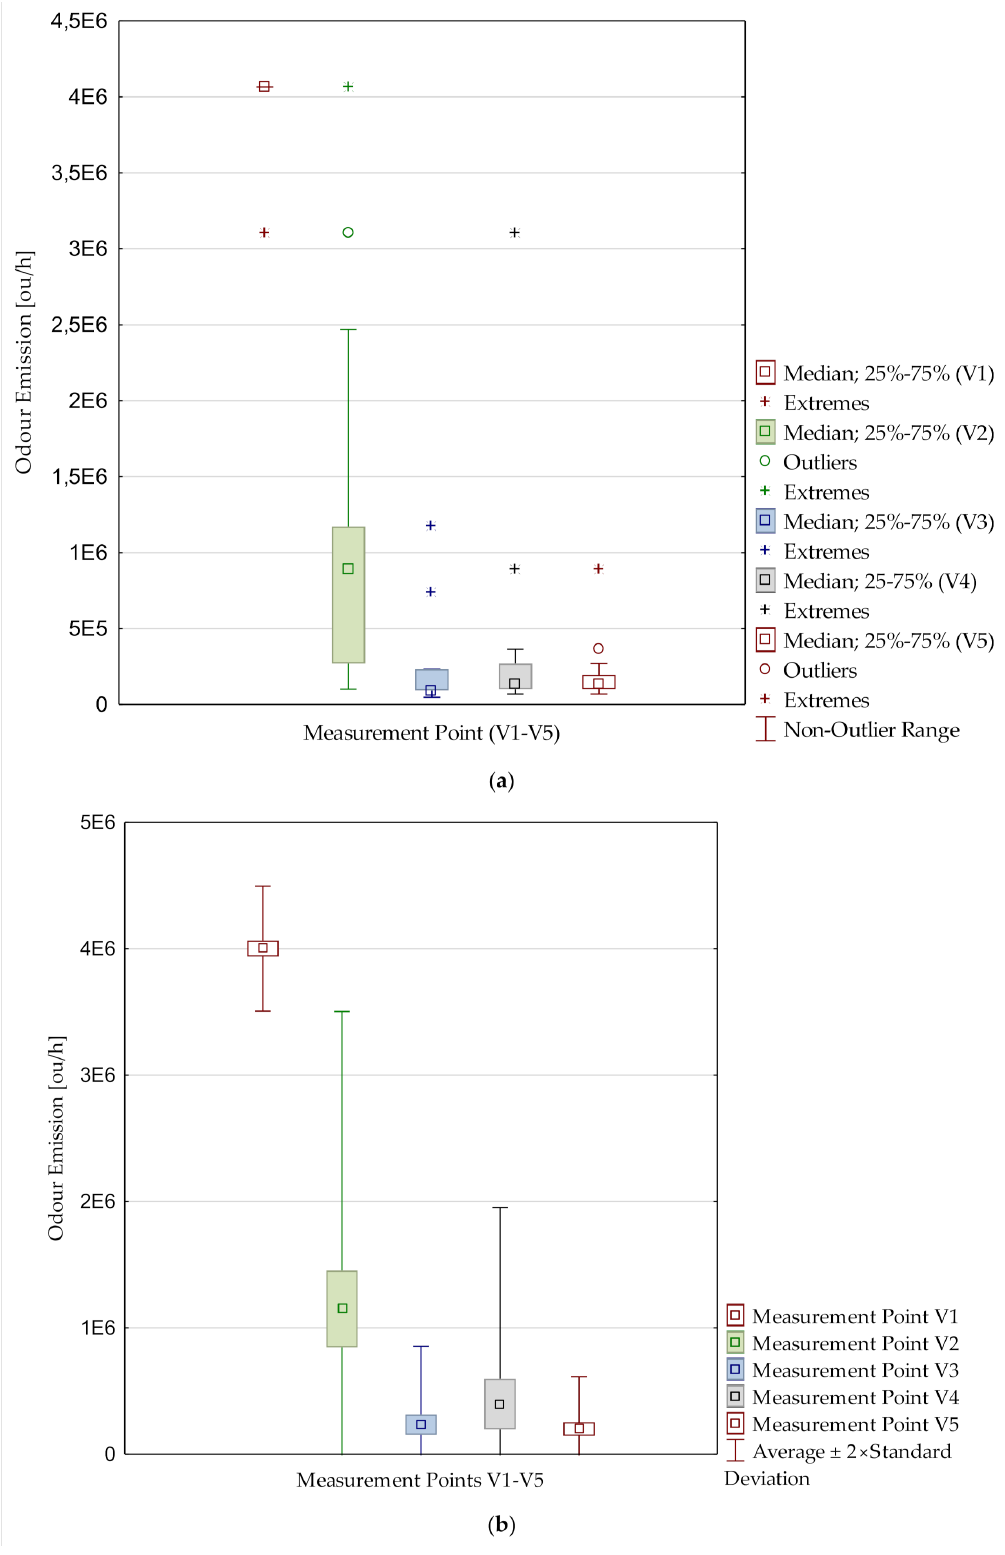
Figure 8. Odour emission levels with median ( a ) and average ( b ) values at all measurement points and in every measurement